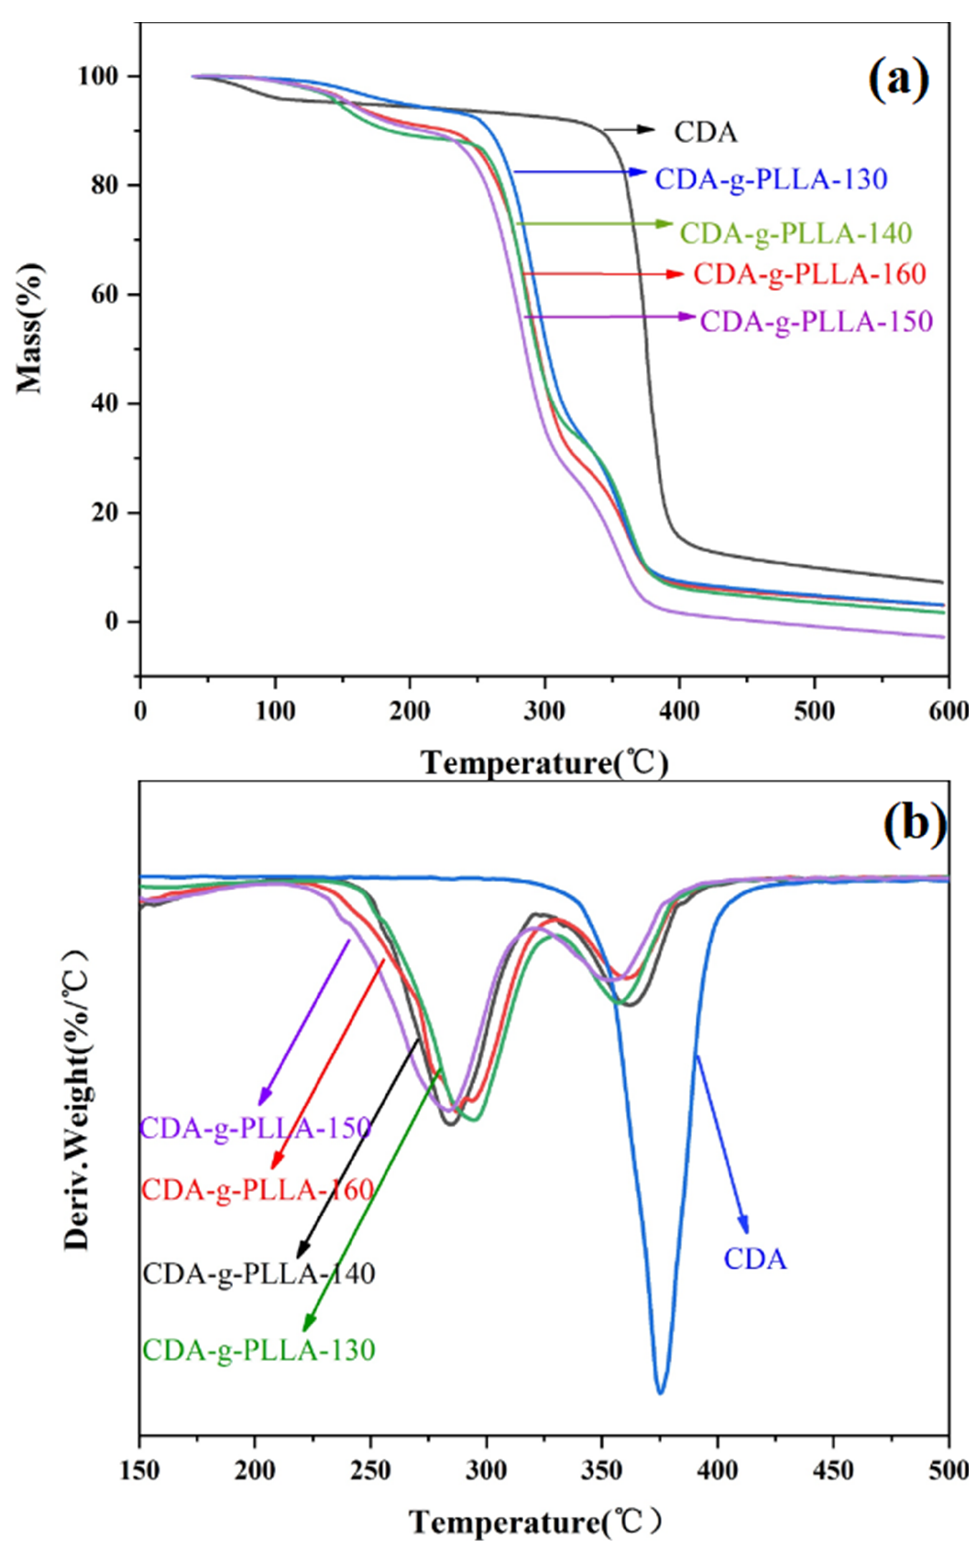
Figure 6. TGA (a) and DTG (b) curves of CDA and CDA − g −